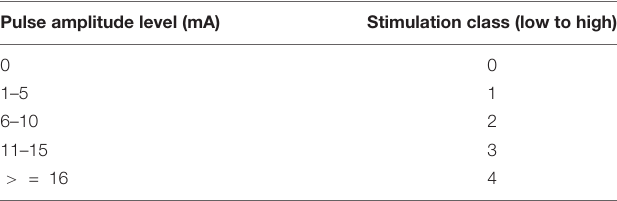
TABLE 1 | Categorized stimulation class into 5 classes based on pulse amplitude